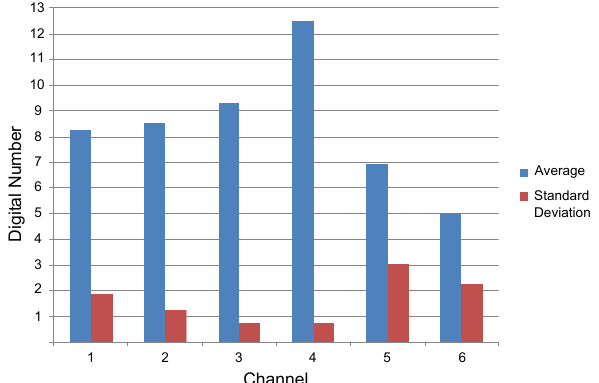
Figure 4: Per-Pixel Noise Average and Standard Deviation for each mini-MCA Channels (exposure: 4,000)